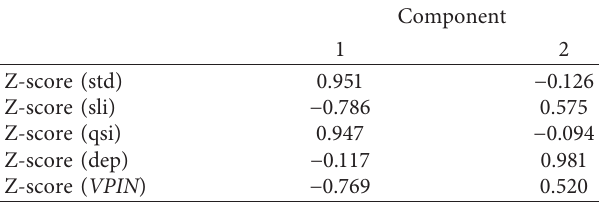
Table 14: Rotation component matrix.